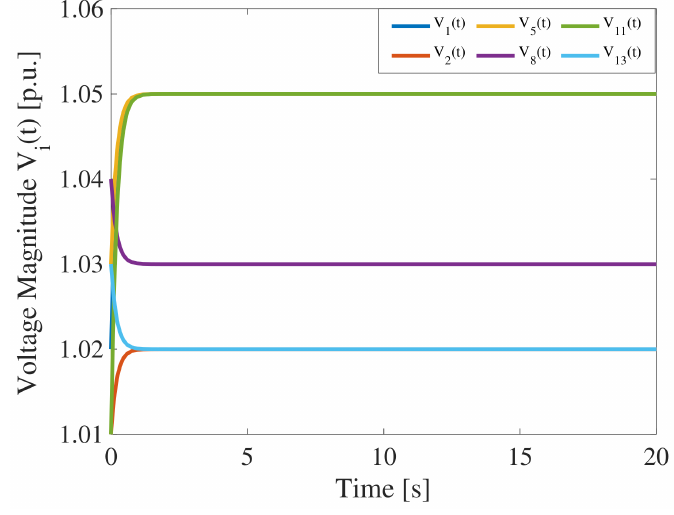
Figure 3. Time history of the voltage magnitude V i ( t ) [ p . u . ] for i ∈ N g .